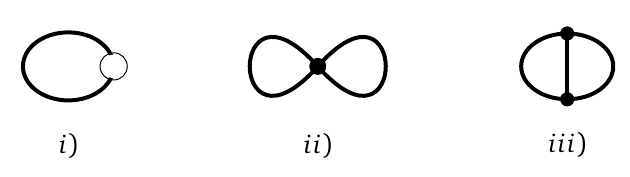
Figure 1: Degenerations of a genus-two Riemann surface corresponding to the boundary strata of the fundamental domain F . The white node in i) corresponds to 2 a torus while the black dots in ii), iii) corresponds to a sphere. The ‘figure-eight’ and ‘sunset’ diagrams in supergravity are obtained by replacing the black dots in ii) and iii) with supergravity 4-point and 3-point interactions, and attaching four external gauge bosons to the